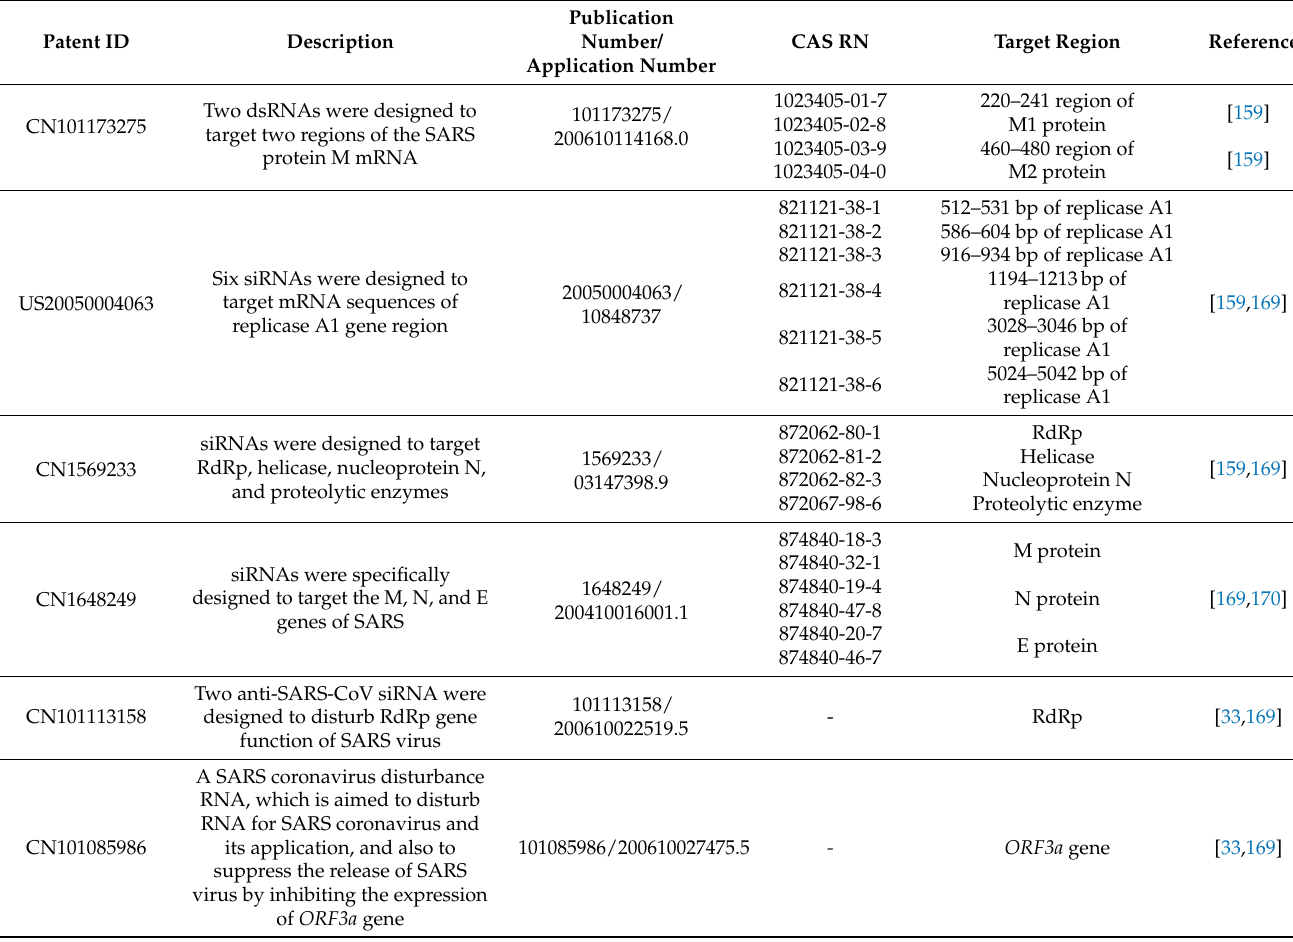
Table 1. Patented siRNAs for the SARS-CoV virus with potential use against